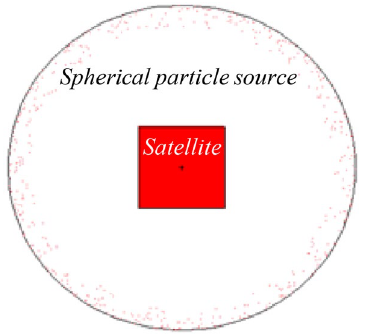
Figure 3. 2D display of the problem structure with a spherical source.